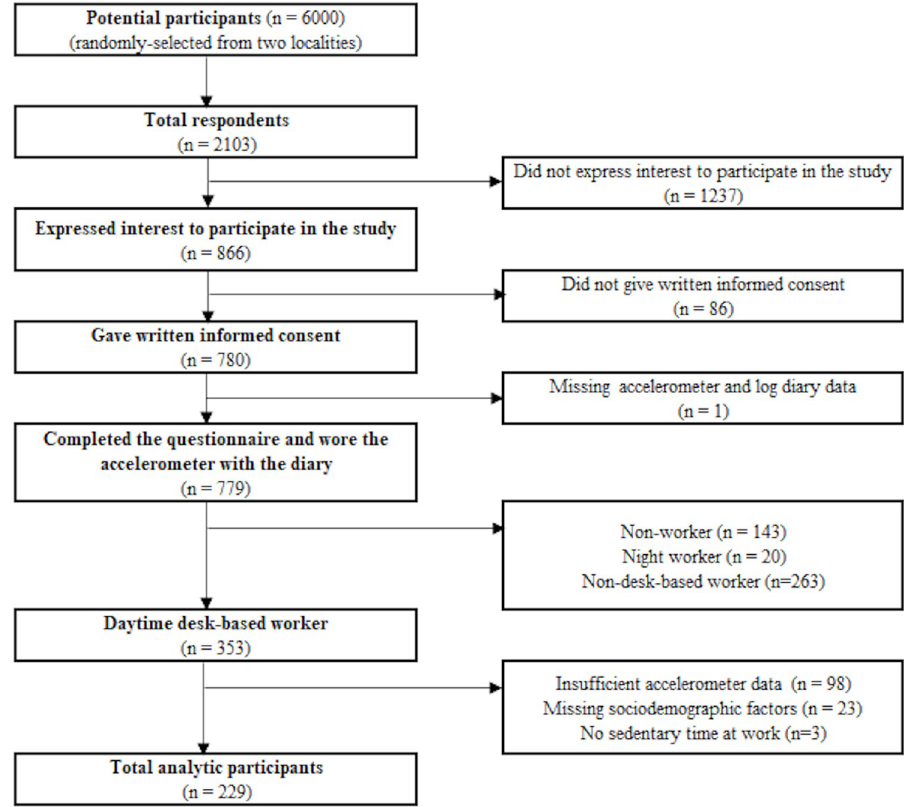
Fig 1. The flowchart of participant